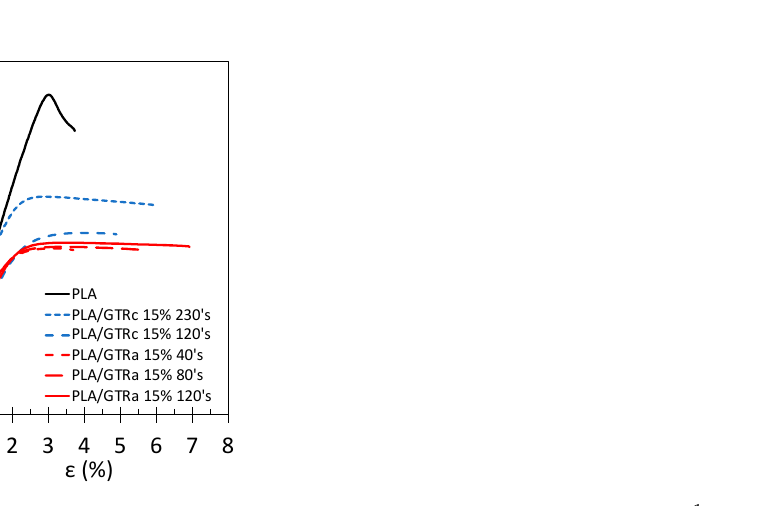
Figure 4. Engineering stress–strain curves of tensile test performed at 10 mm ∙ min − 1 and at room temperature on the neat PLA (black continuous line), PLA/GTR a 15 wt% sieved 40’s mesh (red dashed dotted line), PLA/GTR a 15 wt% sieved 80’s mesh (red dotted line), PLA/GTR a 15 wt% sieved 120’s mesh (red continuous line), PLA/GTR c 15 wt% sieved 120’s mesh (blue large dotted line) and PLA/GTR a 15 wt% sieved 230’s mesh (blue small dotted line). Tensile curves shown in this study correspond to PLA/GTR blends using DCP at 1.5 wt% of the GTR. The effect of DCP content is further detailed in Figure 5.